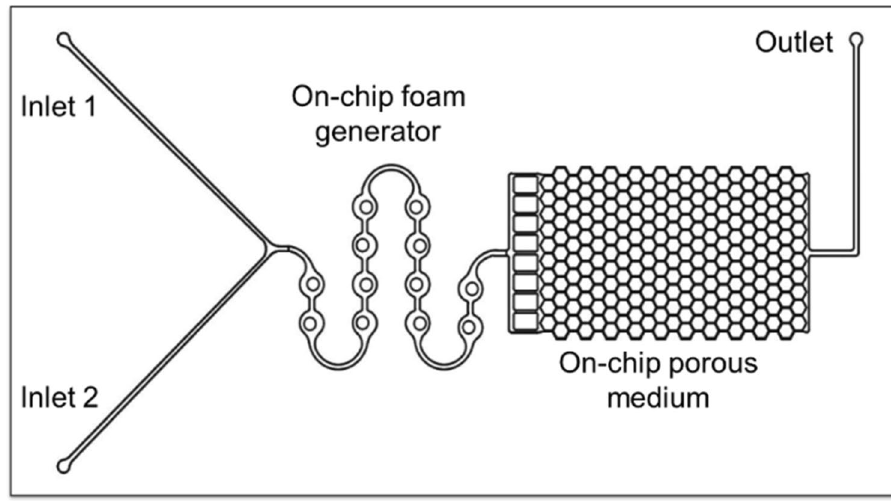
Figure 2. Microfluidic chip pattern designed and developed to study Sc-CO 2 surfactant foams.